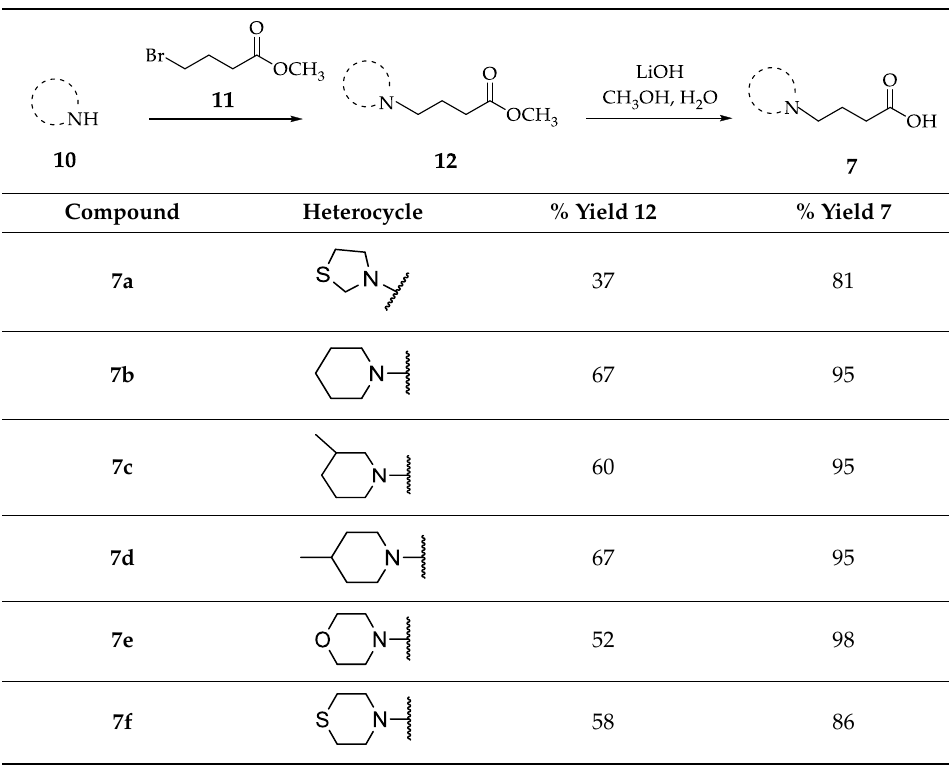
Table 1. Synthesis of analogues 7 Table 1. Synthesis of analogues 7 . Table 1. Synthesis of analogues 7 . Table 1. Synthesis of analogues 7 . Table 1. Synthesis of analogues 7 . Table 1. Synthesis of analogues 7 . Table 1. Synthesis of analogues 7 . Table 1. Synthesis of analogues 7 .